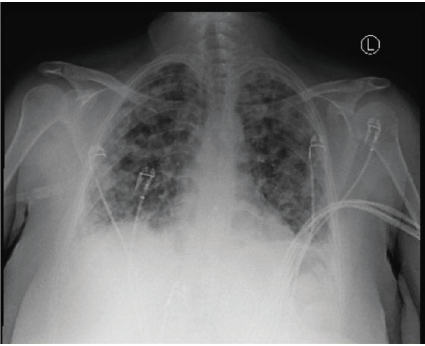
Figure 2: Chest X-ray showing worsening bilateral nodular opacities on hospital day